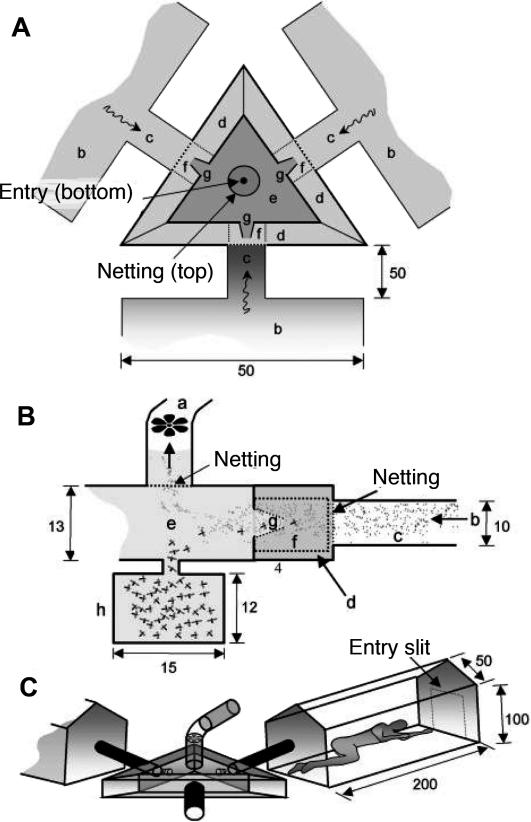
Experimental Set-Up(A)–(C) Top (A), cross-sectional (B), and three-dimensional (C) views of the olfactometer used. The fan (a) draws air (∼130 l/min per tent) from the three tents (b) to the outside environment via PVC pipes (c), trap chambers (d), and a central chamber (e). Each trap chamber contains a collecting cage (f) into which an exit trap opens (g). The fan pipe and release cup (h) are fitted to the top and bottom of the central chamber, respectively. Diagrams are not shown to scale; all dimensions are in centimetres. Source: [12].